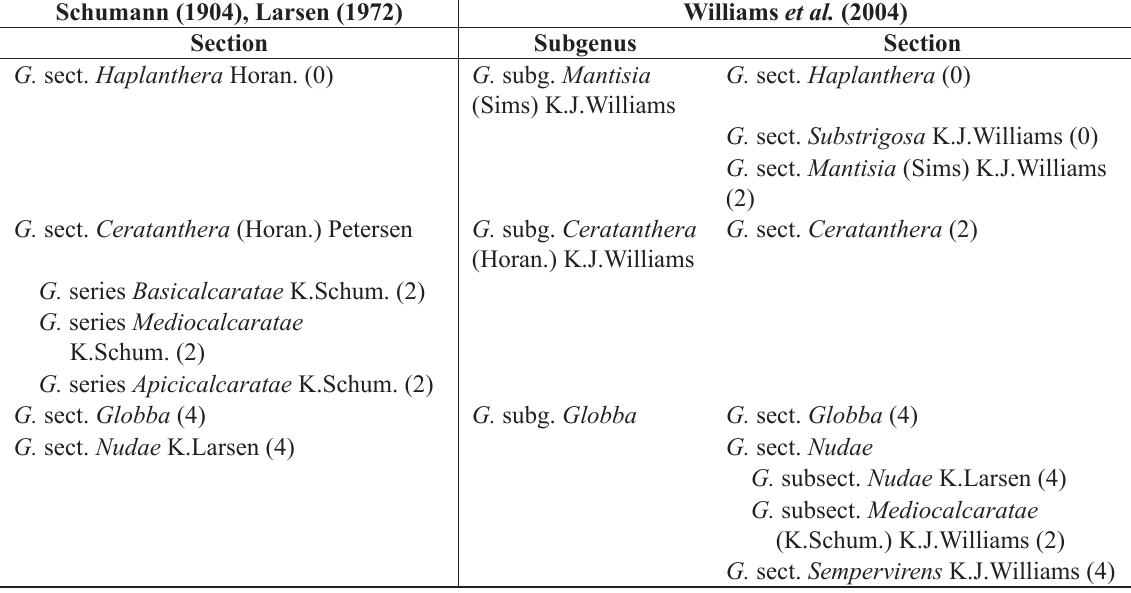
Table 1. Comparison of classifications using morphological characters only (Schumann 1904; Larsen 1972) and molecular and morphological characters combined (Williams et al. 2004); anther appendage numbers are in